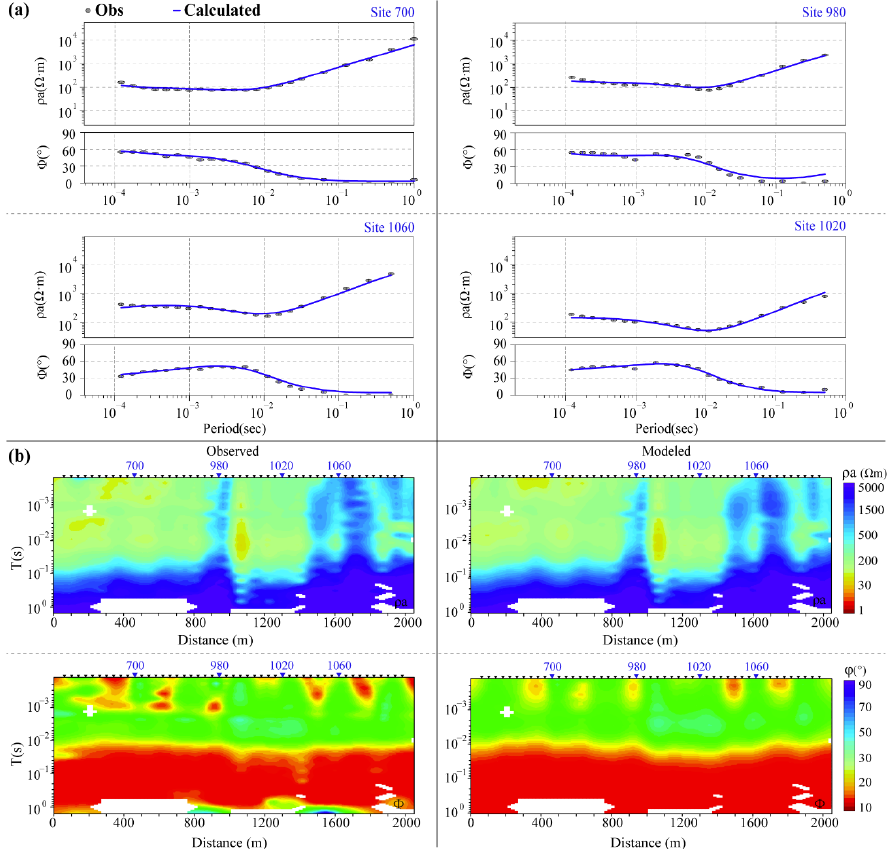
Figure 2. Pseudo−sections of resistivity and phase before and after two-dimensional (2D) inversion. The comparison between the observed data and responses of inversion models. ( a ) The apparent resistivity and phase curves for four selected sites. ( b ) Pseudo-sections of apparent resistivity and phase for the profile L3.